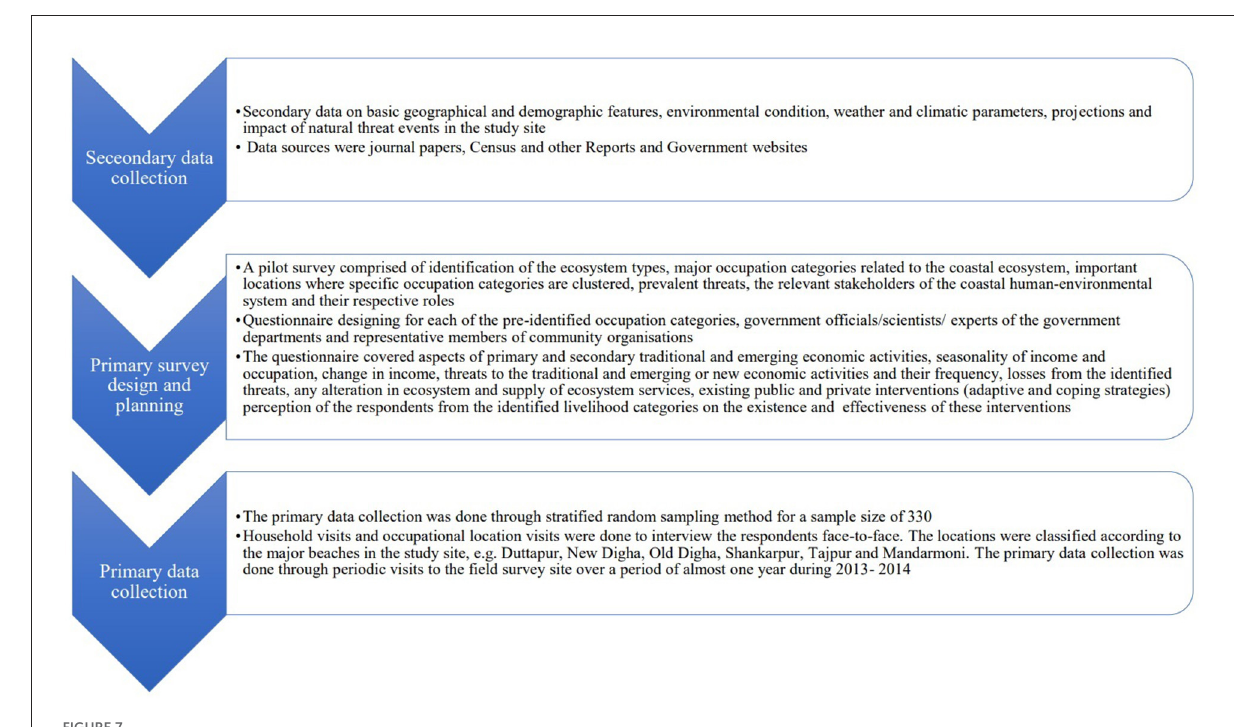
FIGURE7 Primary and secondary data collection